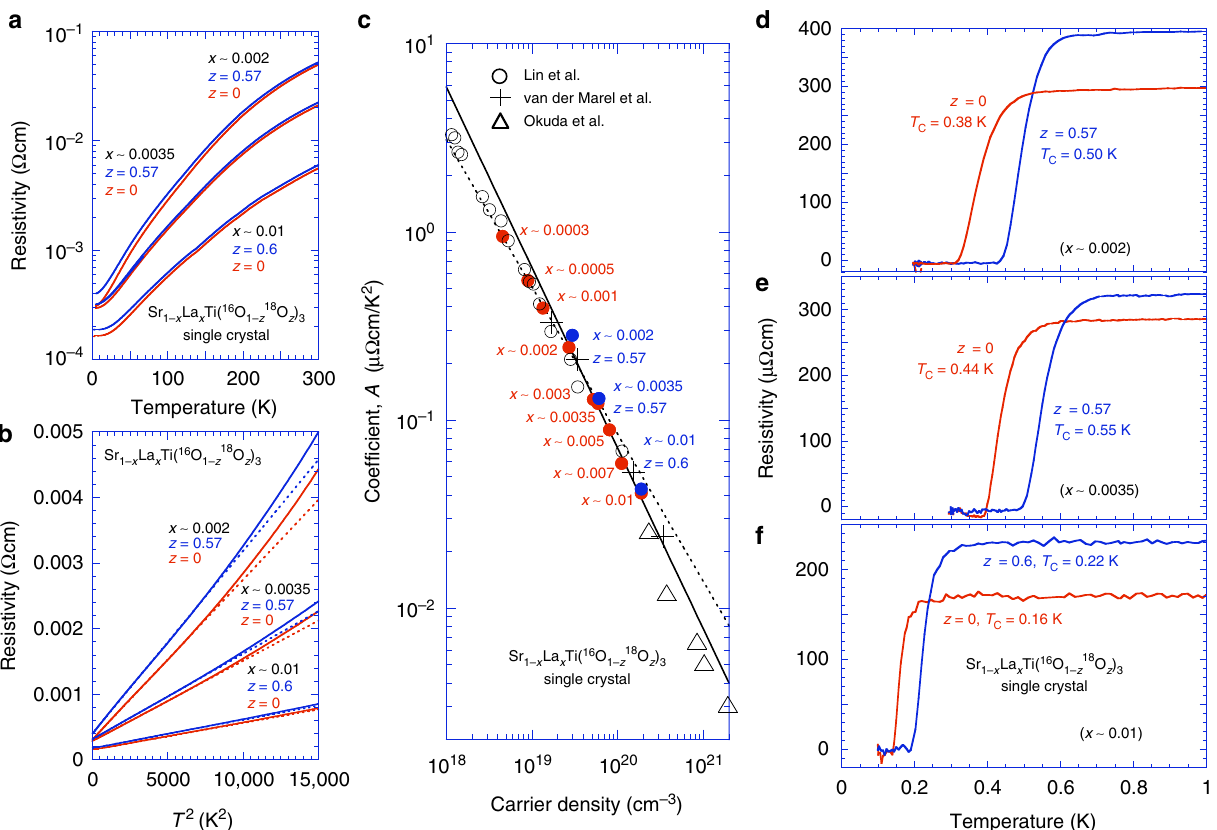
Fig. 2 Resistivity and superconductivity of Sr 1 − x La x Ti( 16 O 1 − z 18 O z ) 3 single crystals. a Temperature dependence of resistivity for 18 O-exchanged Sr 1 − x La x Ti ( 16 O 1 − z 18 O z ) 3 with ( x , z ) = (~0.002, 0.57), (~0.0035, 0.57), and (~0.01, 0.60) (blue lines) compared with that for Sr 1 − x La x TiO 3 with x ~ 0.002, 0.0035, and 0.01 (red lines). b Resistivity ρ vs. T 2 . The dotted lines represent ρ ~ AT 2 relations to fi t the experimental data. The coef fi cient A increases with 18 O exchange, indicating mass enhancement of the carriers. c Logarithmic plot of A as a function of carrier density n for all our Sr 1 − x La x Ti( 16 O 1 − z 18 O z ) 3 samples in Fig. 1a and a with the data in the literature: SrTiO 3 – δ 23 (open circles), SrTi 1 − x Nb x O 3 15 (crosses), and Sr 1 − x La x TiO 3 26 (triangles). The straight lines are guides to the eye. A two-orders-of-magnitude drop of A for increasing n is observed, and a kink appears at n ~ 4 × 10 19 cm − 3 near the critical value for the Lifshitz transition 15,30,31 . d – f Residual resistivity ρ 0 and superconducting transition temperatures T c measured using a 3 He/ 4 He dilution refrigerator below 1 K for the same samples shown in